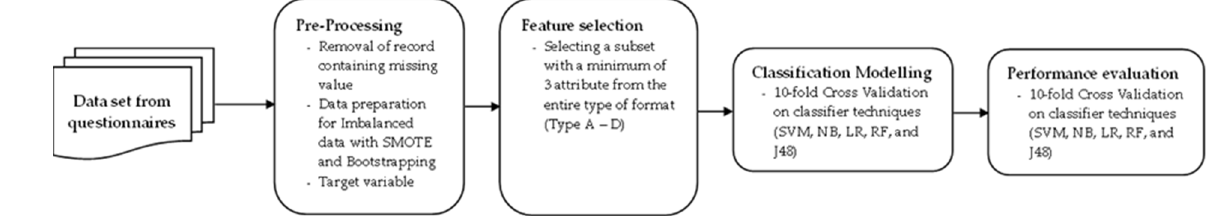
Figure 4. The flow diagram of the proposed model.